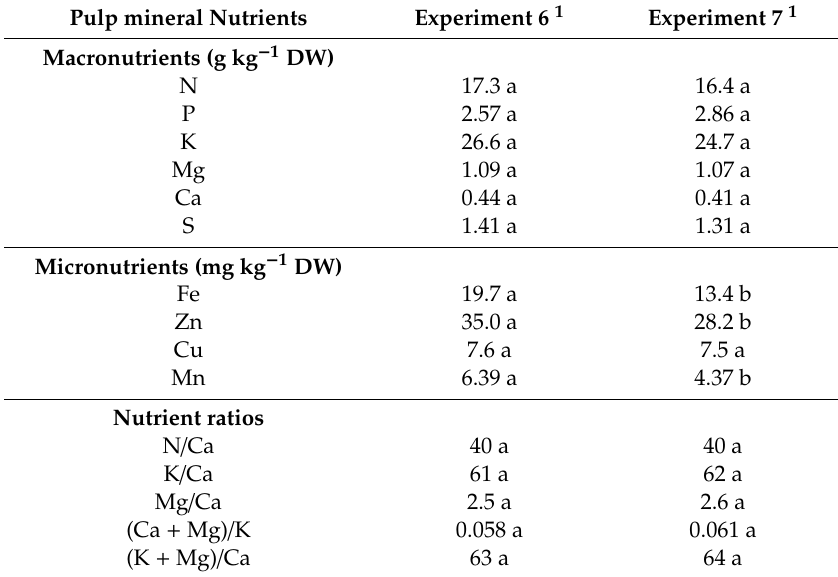
Table 7. Mineral nutrients in pulp of ‘Hass’ avocado fruit harvested in 2018 season.